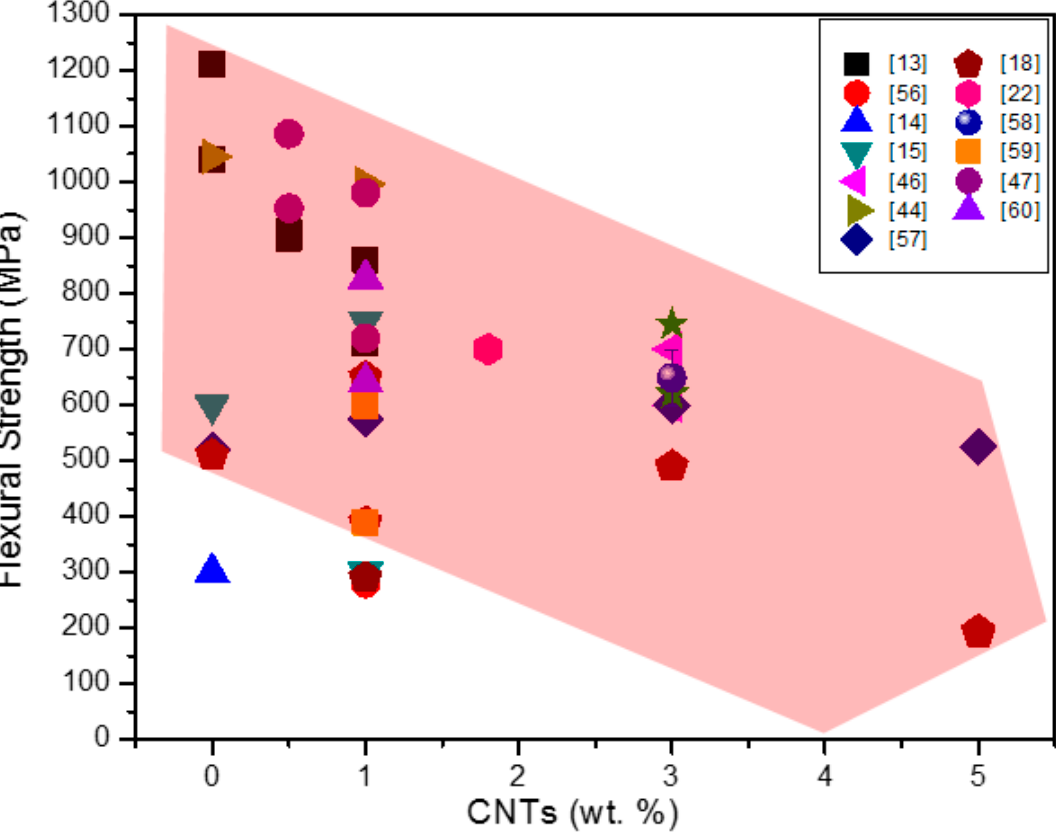
Figure 7. Influence of CNT addition on the flexural strength of CNT-reinforced silicon nitride composites. The results are based on 3-point bending test except the source [44] which is based on 4-point bending strength. The highlighted arrow indicates the decreasing tendency of flexural strength of Si 3 N 4 composites with increasing CNT content. The processing route for the preparation of investigated materials is illustrated in Table 3.